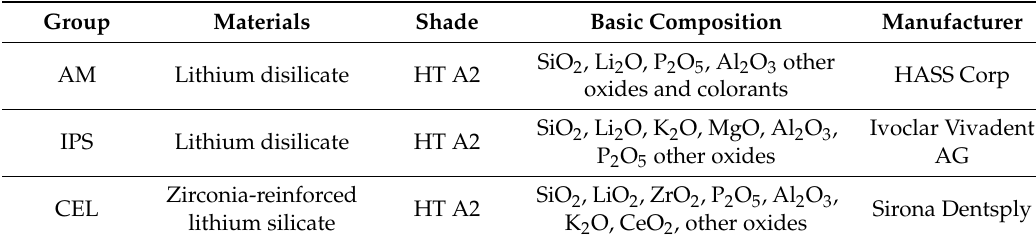
Table 1. Base ceramic